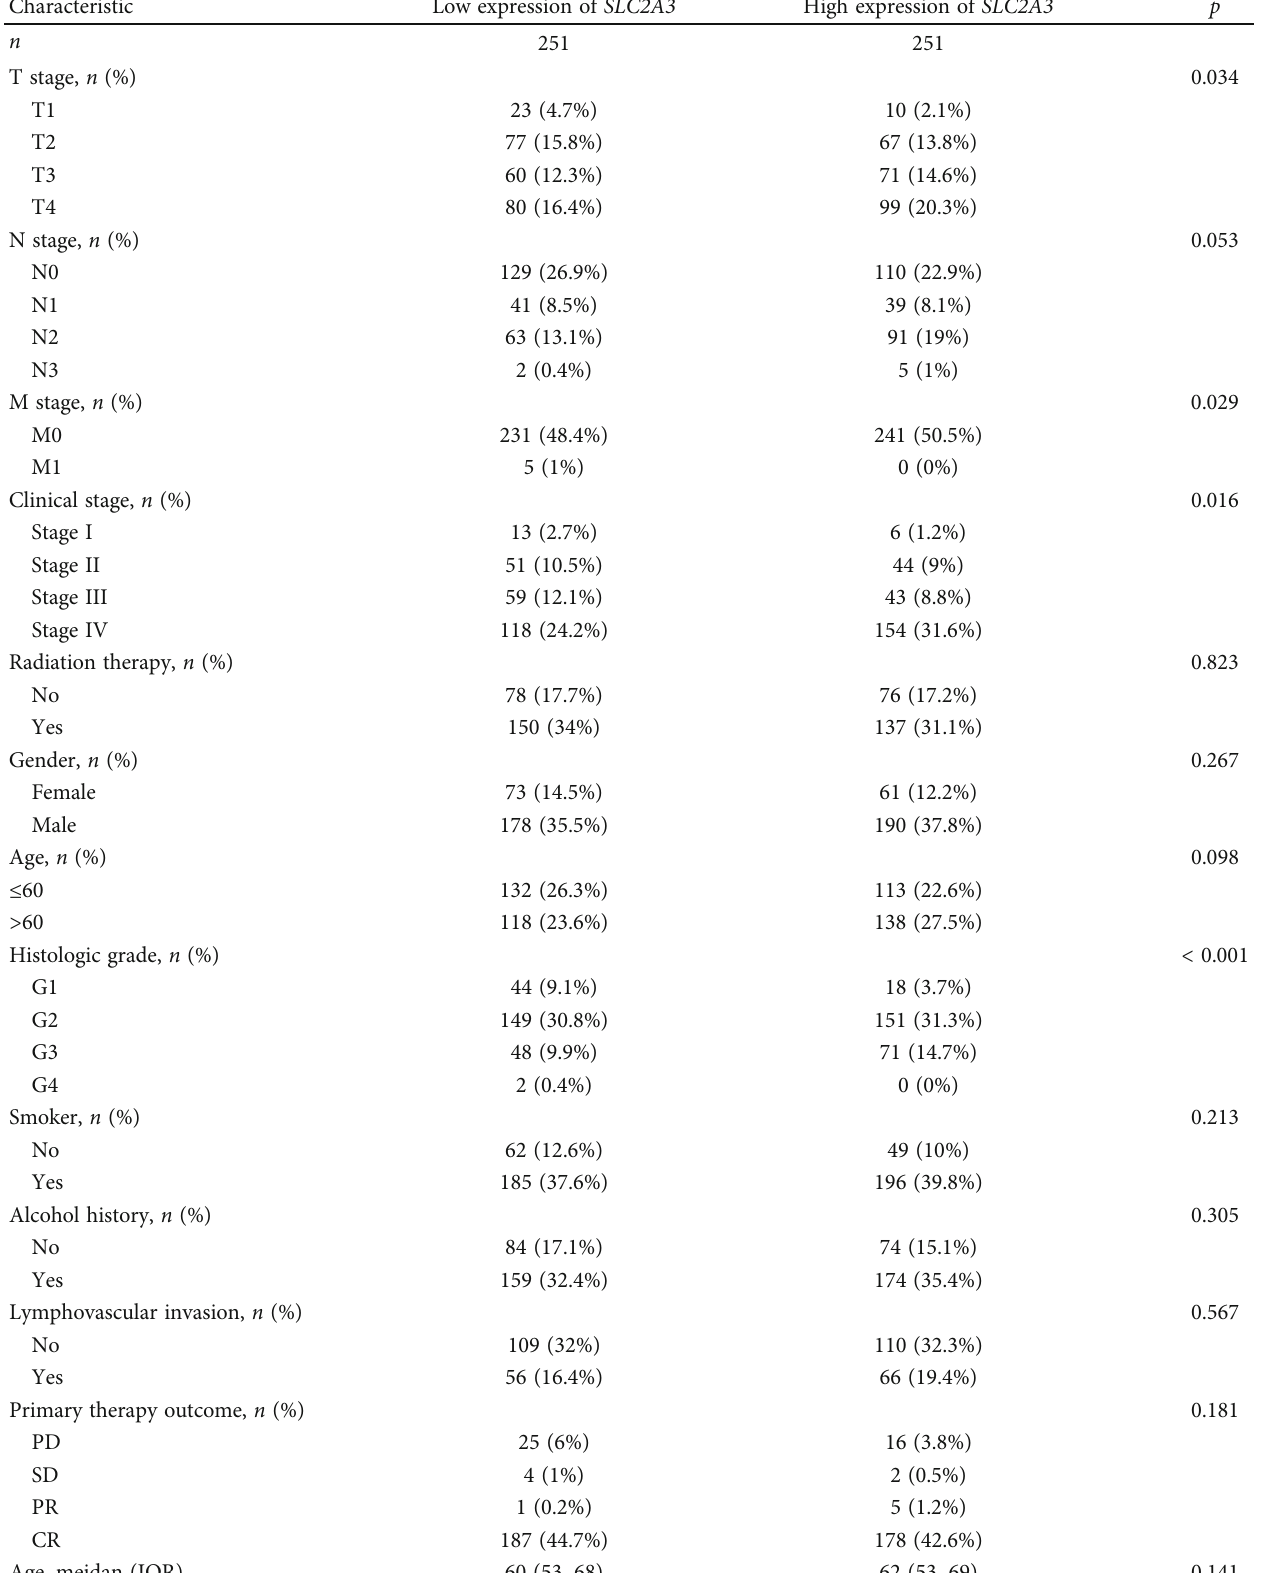
Table 1: Clinical characteristics of head and neck squamous carcinoma